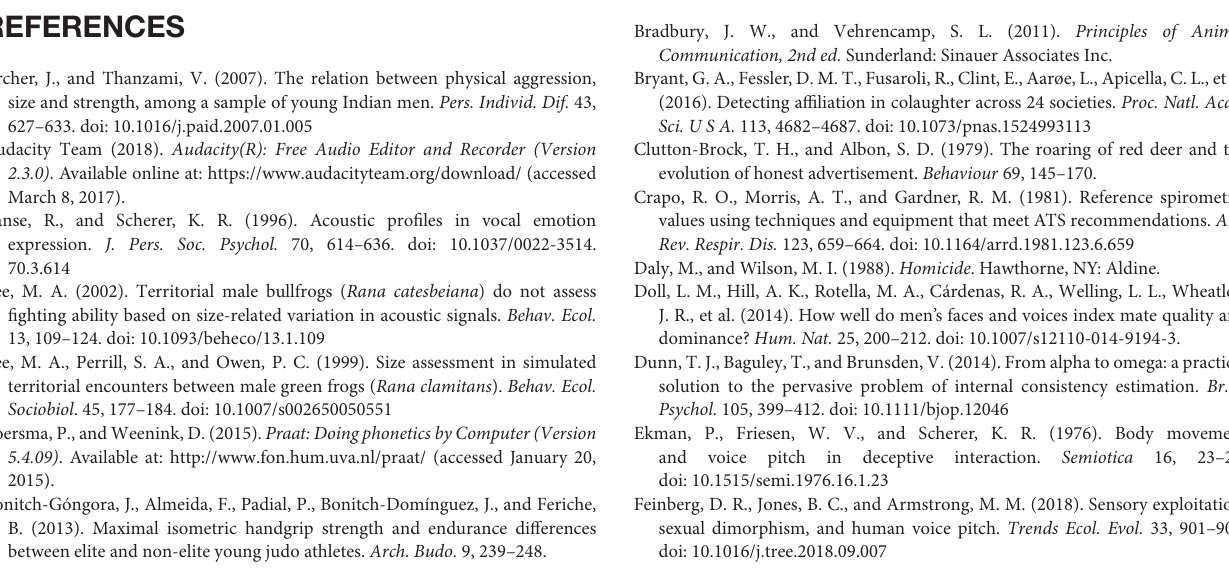
Figure S1 | Sample of failed roar F 0 measurement spectrogram. Figure S2 | Sample of successful roar FFT spectral peak frequency. Table S1–S19 | Supplementary results. Table S20 | Dataset ratings. Table S21 | Dataset targets. Table S22 | Exploratory correlation